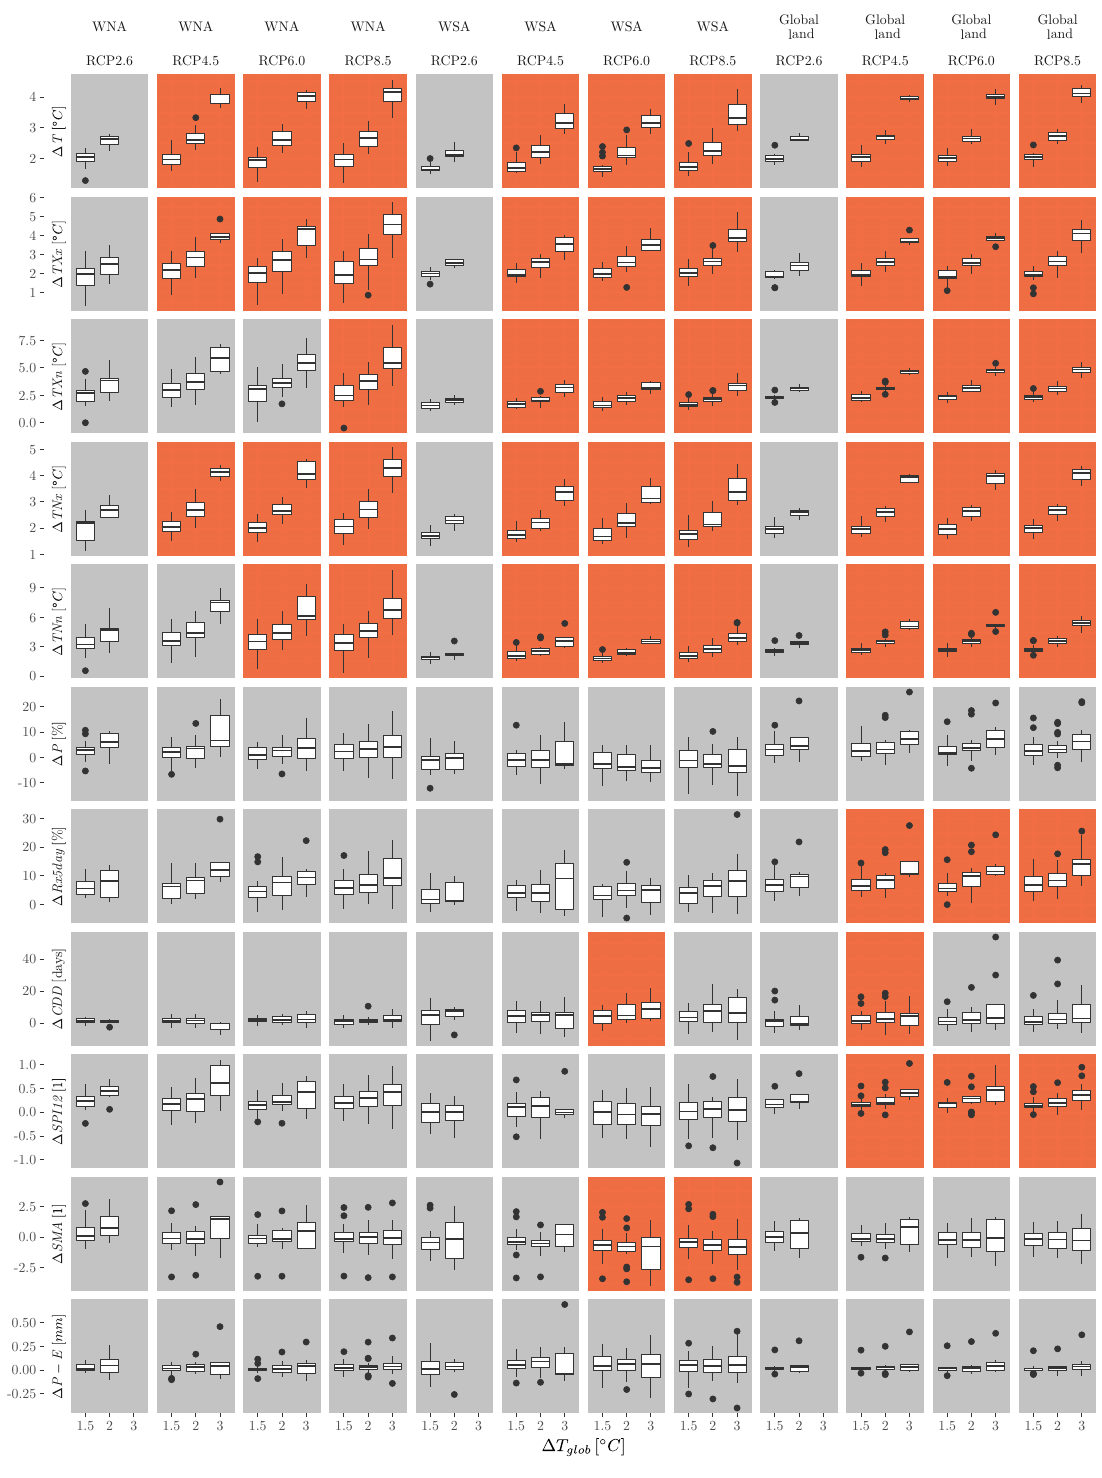
Figure A7. Like Fig. A1 but for SREX regions WNA and WSA, and for global land.